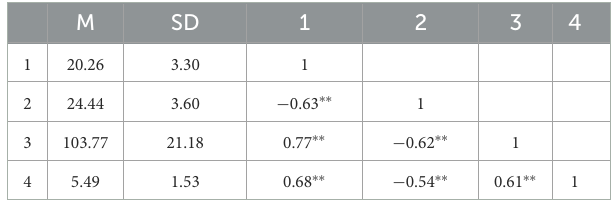
TABLE 2 Statistical description and related analysis